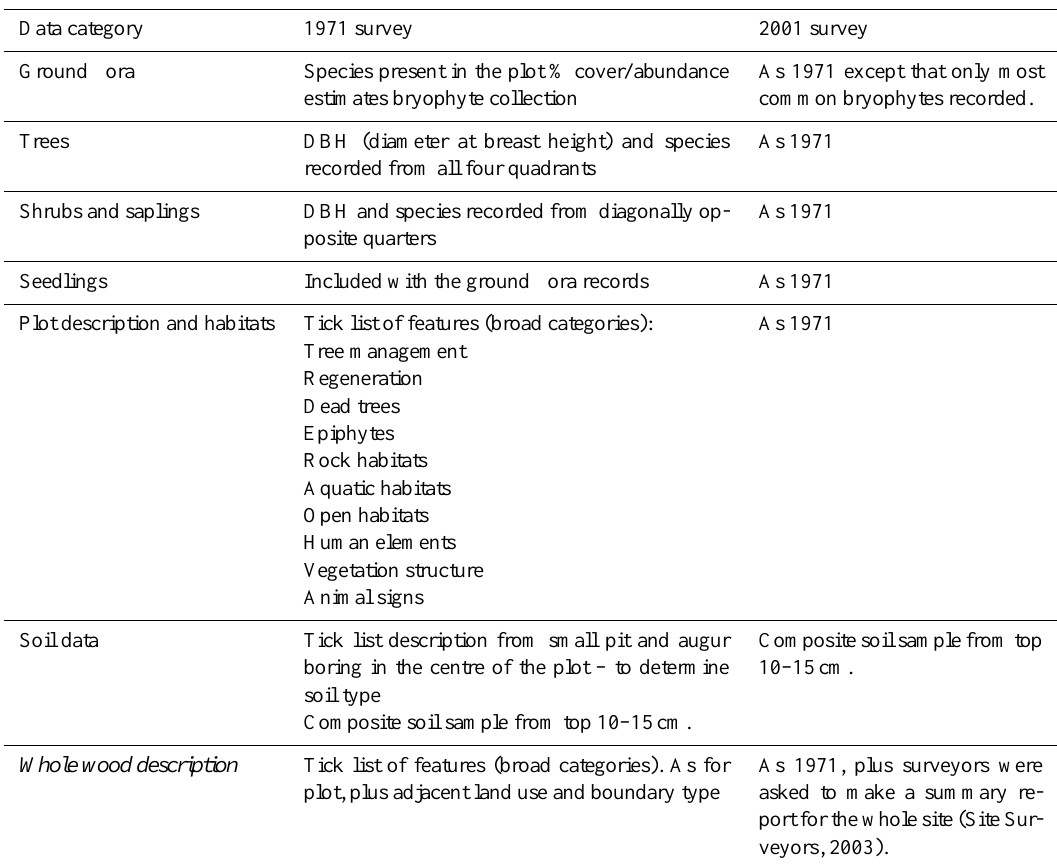
Table 4. Summary of data